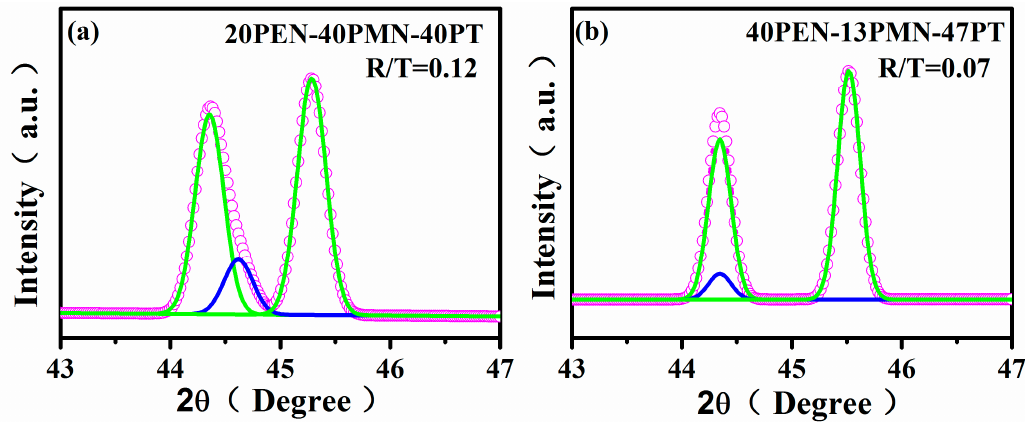
Figure 3. X-ray diffraction patterns fitted with Gaussian functions for (200) peaks at 2 θ = 43–47°: ( a ) 20PEN-40PMN-40PT; ( b ) 40PEN-13PMN-47PT.